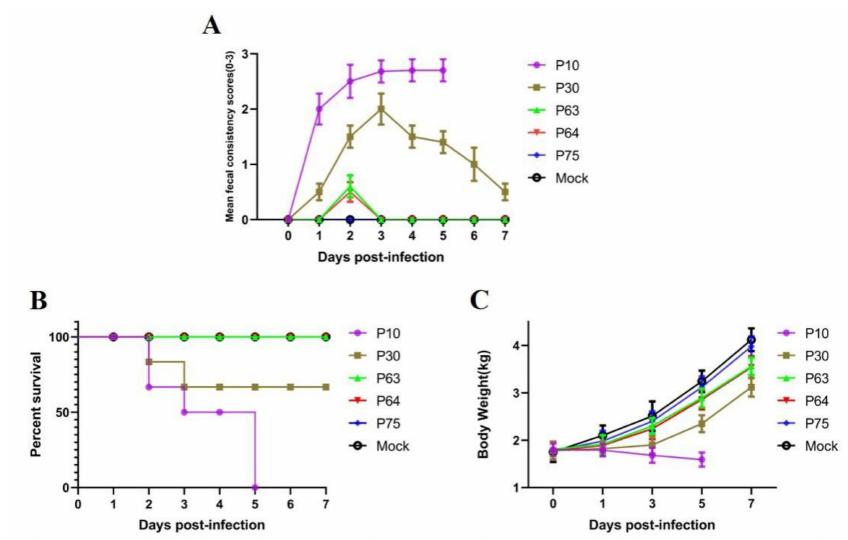
Figure 5. Pathogenicity analysis of SDSX16 di ff erent generation strains. ( A ) The clinical average score of diarrheas in di ff erent groups (SDSX16-P10, -P63, -P64, -P75, and Mock). The severity of diarrhea was scored based on visual examination; 0 = no diarrhea; 1 = mild diarrhea; 2 = fluidic diarrhea; 3 = severe watery diarrhea. ( B ) Piglets infected with SDSX16-P10, -P63, -P64, -P75 survival was monitored. Five piglets per group. ( C ) The average body weight changes in each group.